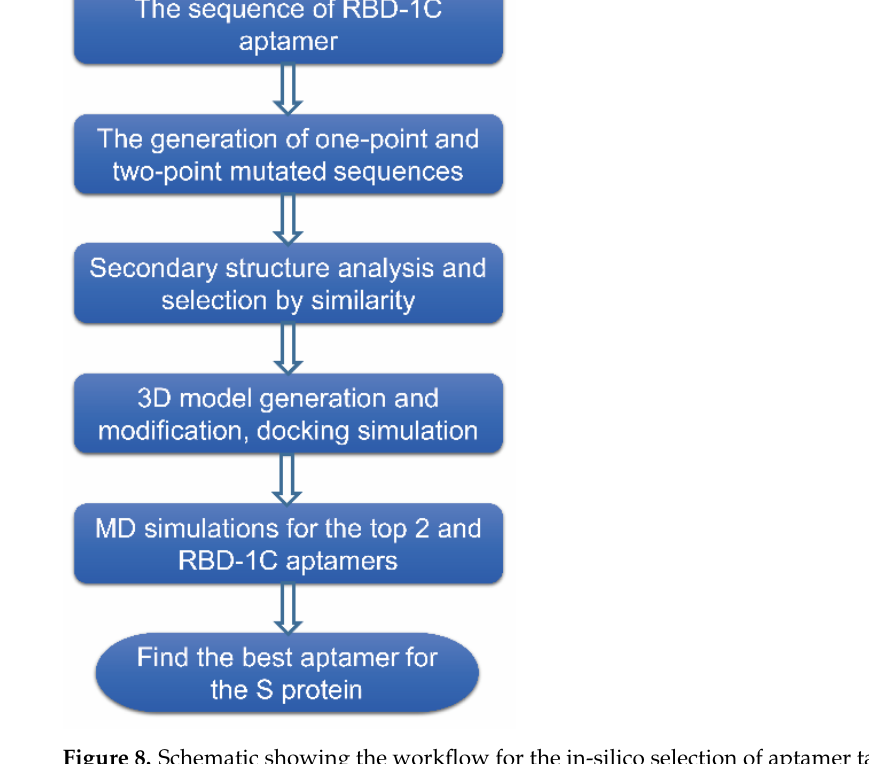
Figure 8. Schematic showing the workflow for the in-silico selection of aptamer target SARS-CoV-2 S protein.